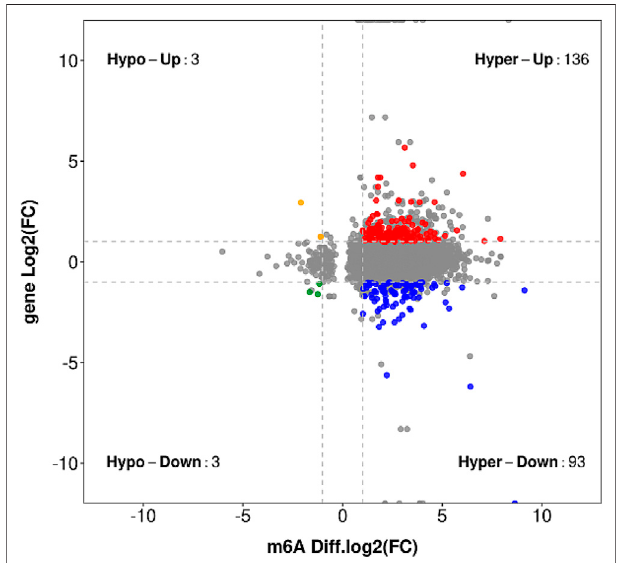
FIGURE 5 | The result obtained by taking the intersection of the gene where the signi fi cant difference m6A peak is located and the signi fi cant difference expression gene isused, and a stricter screening thresholdis